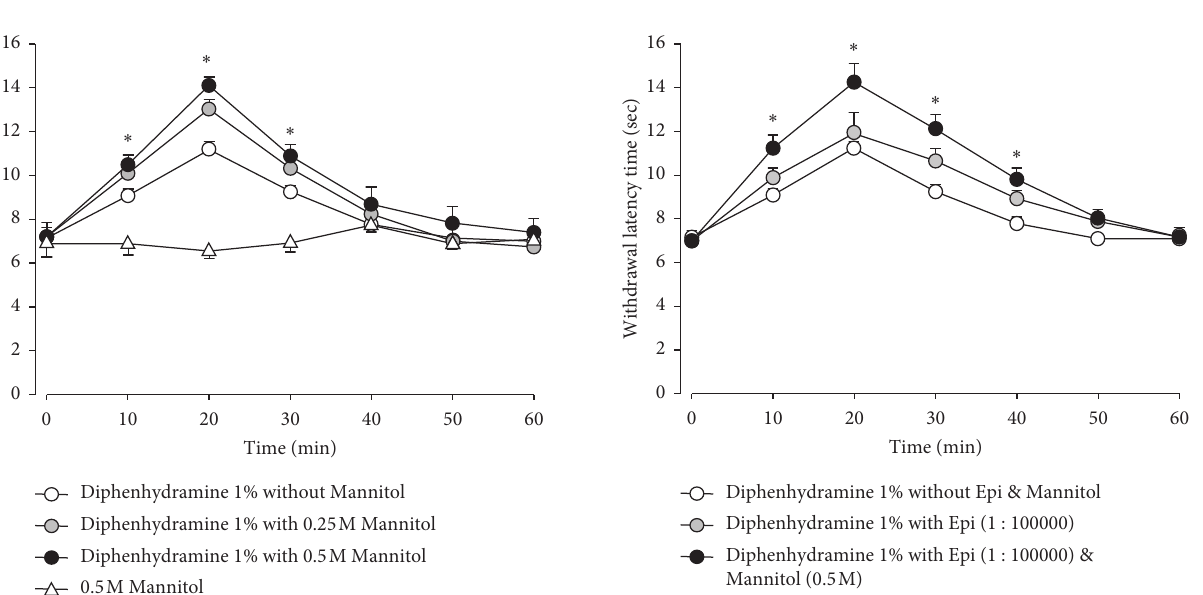
Figure 3: Enhancement of the antinociceptive effects of diphen- hydramine by mannitol. As the control group, the subcutaneous injection of 0.5M mannitol solution alone did not affect the withdrawal latency time. However, the injection of 1% diphen- hydramine combined with 0.5M mannitol significantly enhanced antinociception compared with 1% diphenhydramine alone. The values shown are the mean ± SEM, and there were seven animals in each group. ∗ P < 0 . 05, diphenhydramine with mannitol vs. di- phenhydramine without mannitol.